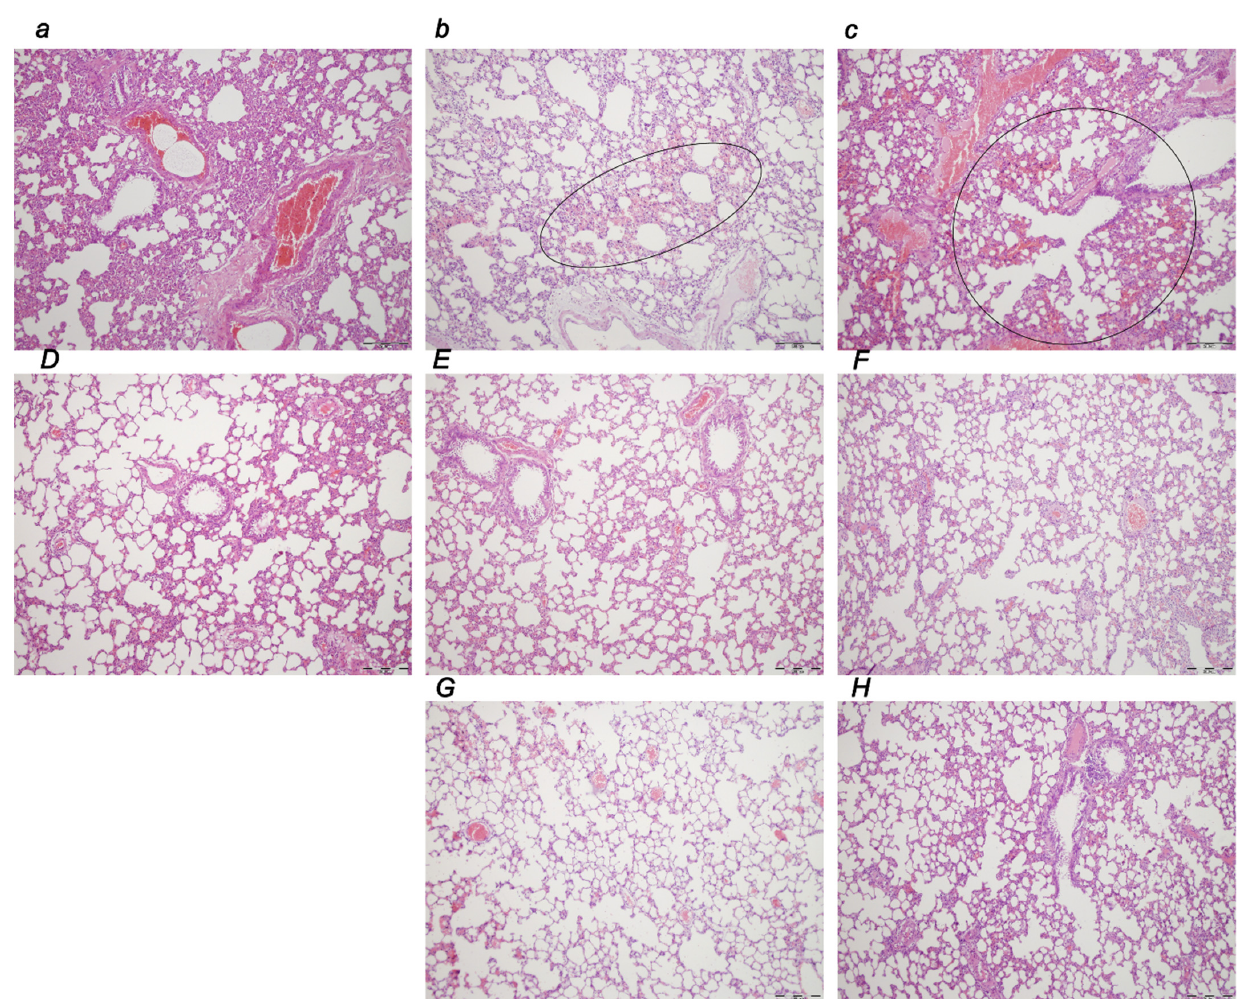
Figure 8. Lung tissue damage illustrative microscopic presentation (HE staining; magnification 100×; scale bar 200 μ m) in rats with obstructed bile duct ( a – H ) at the end of the ligation time periods of 30 min, 5 h, and 24 h; as an early regimen at 0–30 min ( a , D ), 0–5 h ( b , E ), and 0–24 h ( c , F ) application sacrifice period; and as delayed regimen at 4.30 h–5 h ( G ) and 5 h–24 h ( H ) application sacrifice period in controls ( a – c ) and BPC 157-treated rats ( D – H ). In controls, marked lung parenchyma congestion was consistently noted from 30 min ( a ), in addition to intra-alveolar hemorrhage (marked area) at 5 h ( b ) and 24 h ( c ) ligation time. In the BPC 157 early regimen ( D – F ), there were no changes after 30 min ligation time ( D ), while mild lung tissue congestion was found